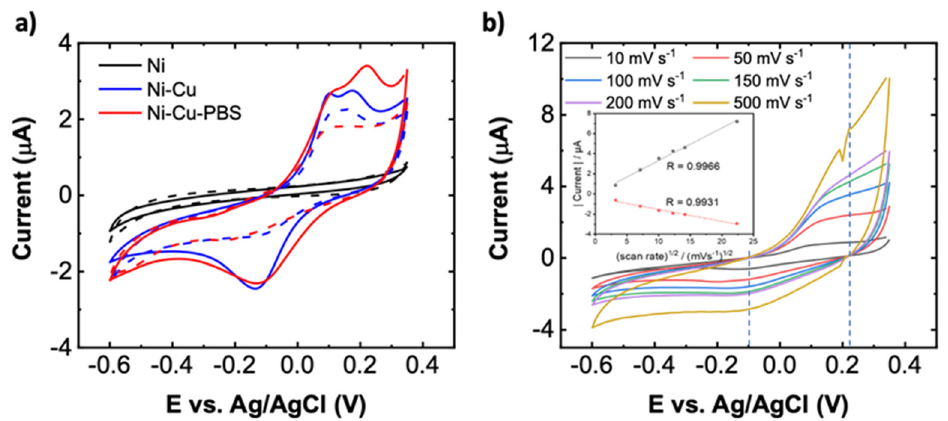
Figure 4. ( a ) Cyclic voltammogram (CV) at 0 (dashed lines) and 5 mM (solid lines) glucose in 0.1 M Na 2 SO 4 for Ni, Cu-Ni, and PBS-Cu-Ni electrodes. The scan rate of 50 mV/s is used. ( b ) CV curves at different scan rates from 10 to 500 mVs − 1 with 1 mM glucose in 0.1 M Na 2 SO 4 with a PBS-Cu-Ni electrode. The inset shows the relationship between the oxidation (black curve) and reduction (red curve) current at 0.22 V and − 0.1 V (indicated by vertical dashed lines), respectively, vs. the square root of the scan rate.